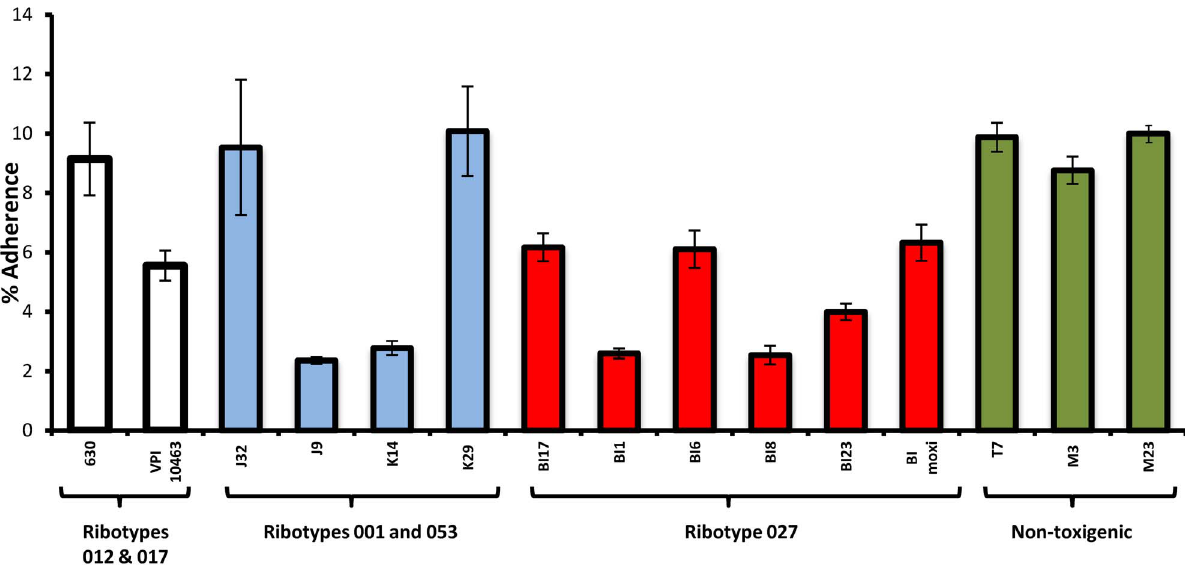
Figure 1. C.difficile strains display variable adherence to human intestinal epithelial cells. Strains in the same genetic group are shown in the same bar color. Specifically, strains 630 and VPI10463 are indicated as clear bars, the ribotype 001 strains as blue bars, epidemic-associated, ribotype 027 strains as red bars, and non-toxigenic strains as green bars. Percentage adherence with standard errors of the mean are depicted; all experiments were performed at least in quadruplicate. For strains 630, J9, K14, BI-1, BI-8 and BI-17, each experiment was repeated in entirety on at least three independent occasions.